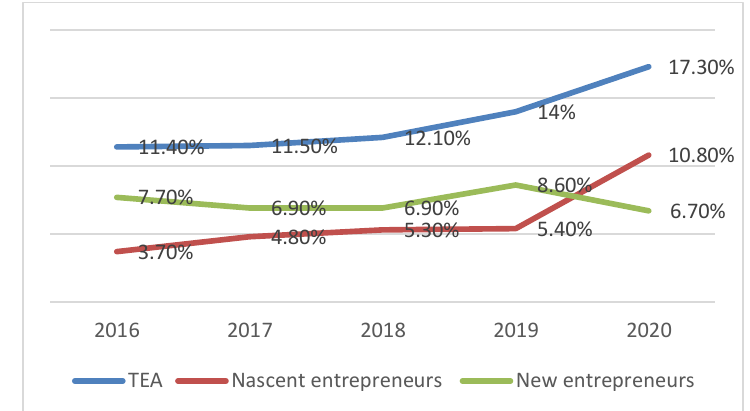
Figure 2 : Nascent Entrepreneurs, New Entrepreneurs and TEA; Source: Global Entrepreneurship Monitor, Kingdom of Saudi Arabia National Report 2020-2021